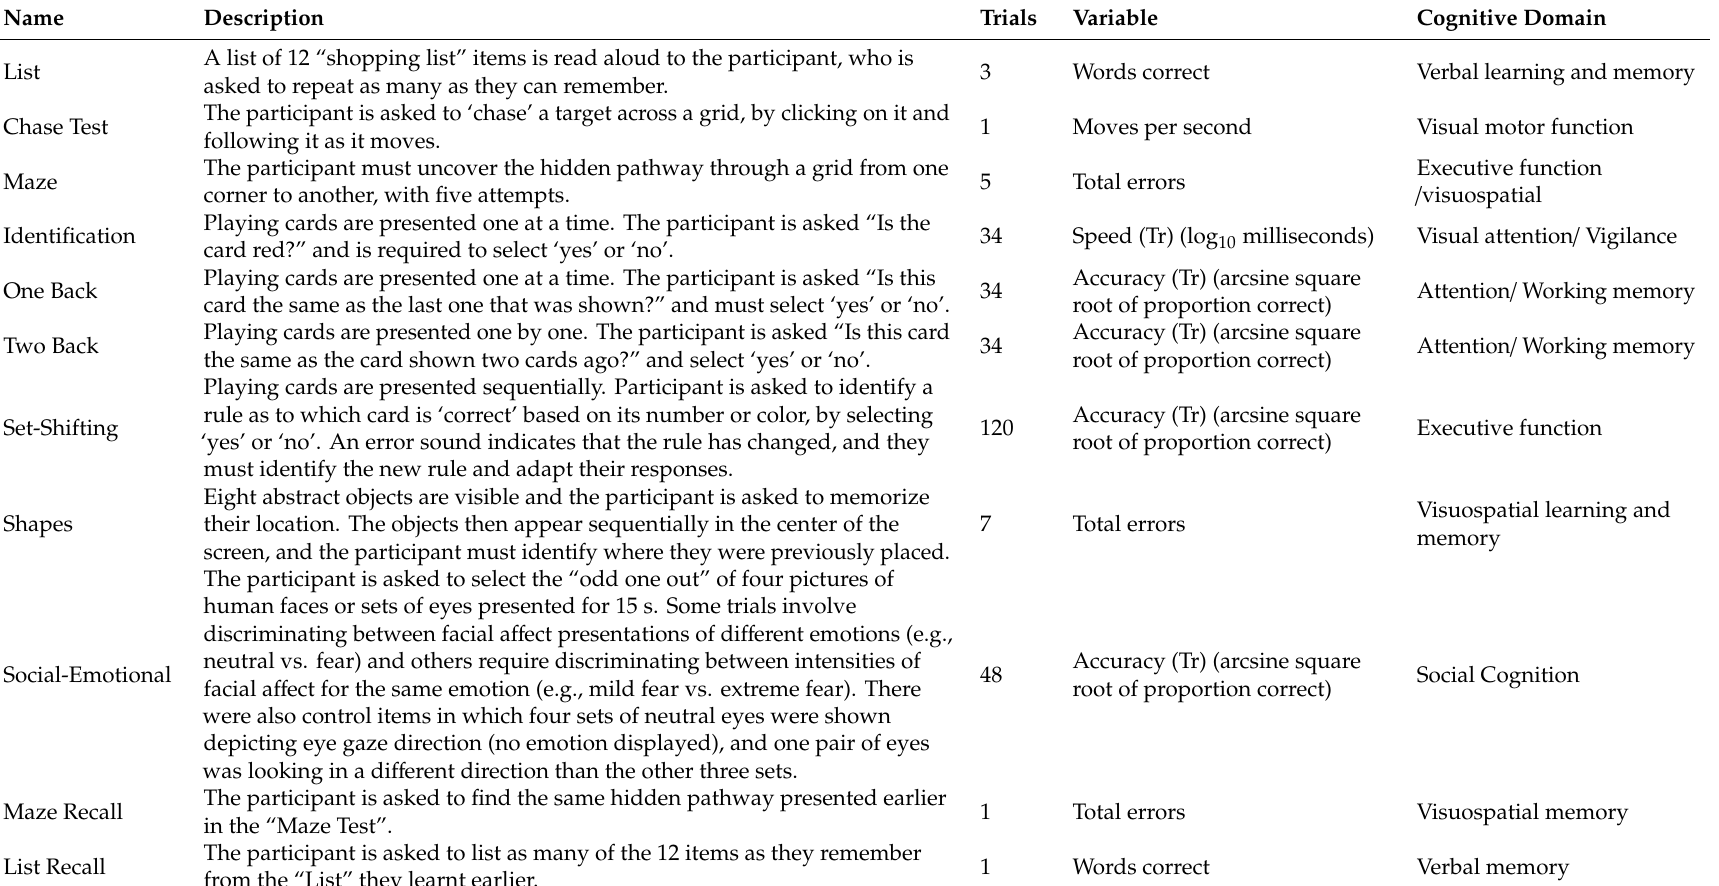
Table 1. List of CogState cognitive evaluation software tasks, including description of task, number of trials performed, output variable, and cognitive domain(s) assessed, presented in order of